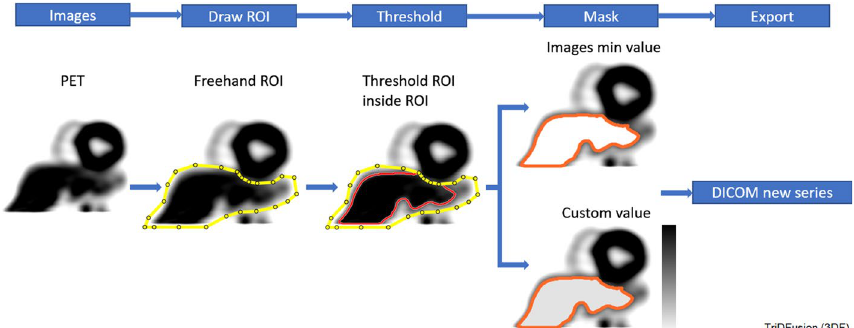
Fig. 12 The workflow to remove confounding structures. The example depicts a heart/liver mask using positron emission tomography (PET) images. The yellow border indicates a constraint whereas the orange border indicates a contour created by a threshold. The gray area indicates the mask of the contour. ROI,